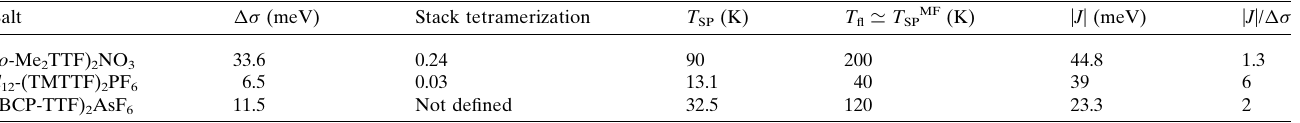
Table 4 Characteristics of various SP